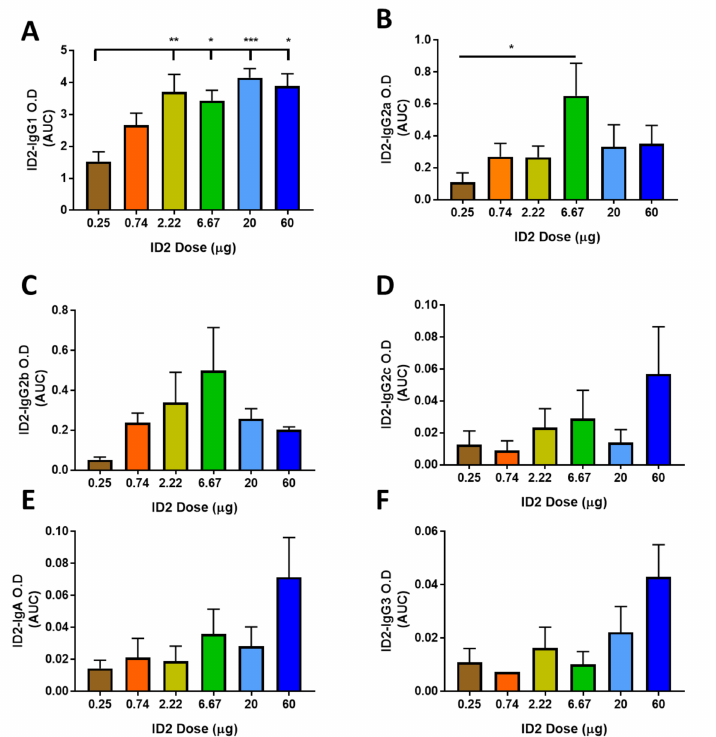
Figure 4. Titer of ID2-specific isotypes induced by varying doses of ID2. Titers of ID2-specific isotypes at the termination of ID2 + GLA-SE immunization. Terminal sera were collected two weeks post final vaccination and analyzed for ( A ) IgG1, ( B ) IgG2a, ( C ) IgG2b, ( D ) IgG2c, ( E ) IgA and ( F ) IgG3. n = 6 mice for each group, sera were evaluated for each mouse in triplicate and displayed as mean ± SEM for area under the curve (AUC) over the dilution range displayed in Figure 1. Statistical significance was determined using a one-way ANOVA with Tukey’s test for multiple comparisons. Significance values are indicated as * p < 0.05, ** p < 0.01, *** p <